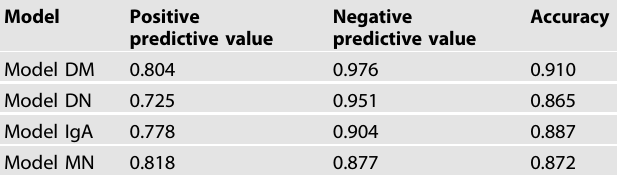
Table 2. Evaluation parameters of the diagnostic model based on the logistics regression